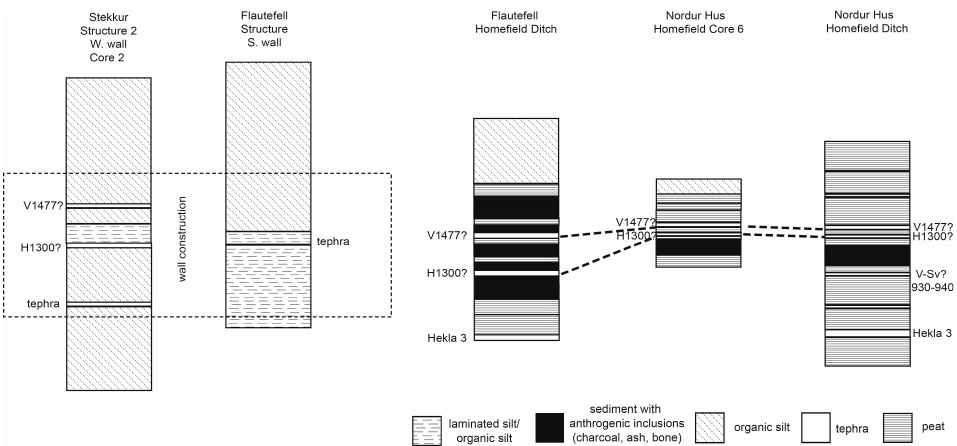
Figure 8. Synthesis of profiles and soils cores in abandoned turf structures and in the homefield at the NDH, FLA, and STK sites. the NDH, FLA, and STK